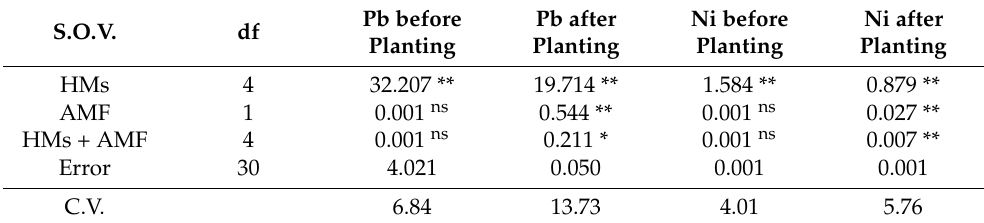
Table 5. ANOVA for the effects of arbuscular mycorrhiza fungi (AMF) inoculation under Pb and Ni stress on the soil Pb and Ni contents, before and after planting of lavender.